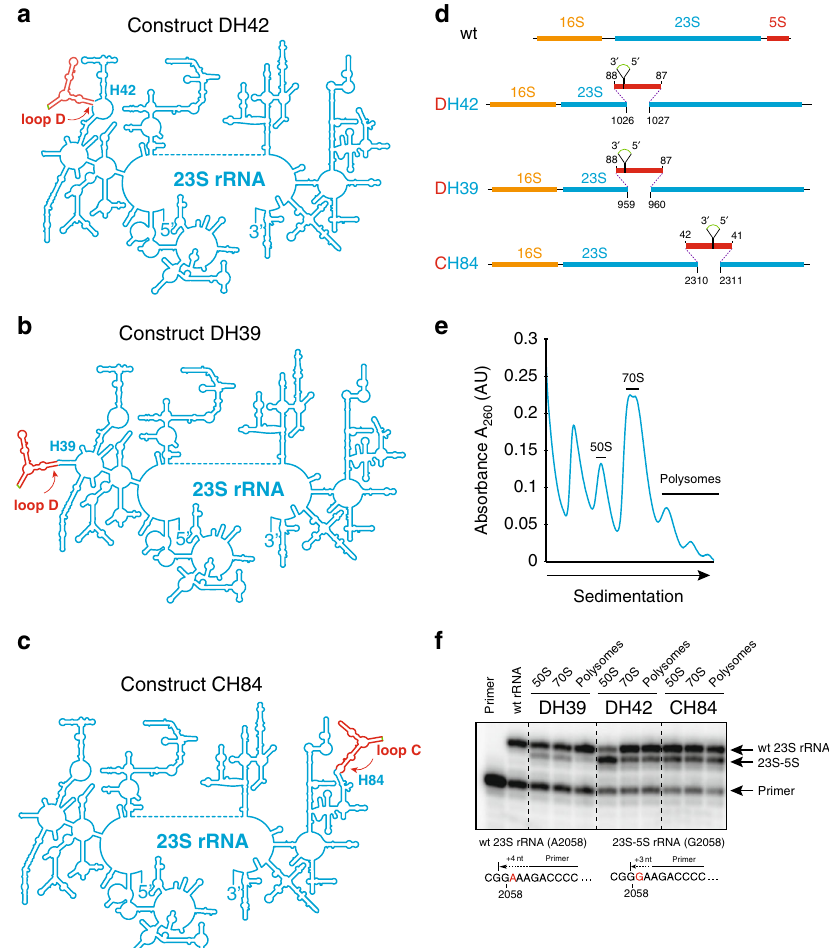
Fig. 2 Engineering 23S-cp5S rRNA. a – c Secondary structures of the three engineered 23S-cp5S rRNA constructs DH42 ( a ), DH39 ( b ) and CH84 ( c ). 23S rRNA is in blue and integrated cp5S rRNA is in red; the connector linking 5 ′ and 3 ′ end of wt 5S rRNA is in green. d Schematic representation of the structures of wt and engineered 23S-cp5S rRNA operons. In cp5S, native 5 ′ and 3 ′ 5S rRNA ends are linked by a 4-nt connector (green). The resulting cp5S rRNA is “ opened ” in loop D (constructs DH42 and DH39) or loop C (construct CH84) and inserted via short tethers (dotted lines) connecting the indicated positions of the 23S rRNA and 5S rRNA. e Sucrose gradient separation of the ribosomal material from E. coli POP2136 cells expressing a mixed population of wt and 23S-cp5S ribosomes (construct DH42). The fractions used for preparation of the RNA from the large subunits (50S), ribosomes (70S), and polysomes are indicated. f Primer extension analysis of the 50S, 70S and polysomal rRNA prepared from randomly picked clones transformed with pDH42, pDH39, or pCH84 plasmids. In the presence of ddCTP, the primer is extended by 4 nt on the wt (A2058) rRNA template or by 3 nt on the 23S-cp5S rRNA template products obtained with wt 23S rRNA. Note the presence of the mutant rRNA-speci fi c band in the polysome fractions of the DH42 and CH84 constructs. The uncropped gel can be found in the Source data fi le. The results shown in e and f are typical representatives of 2 independent